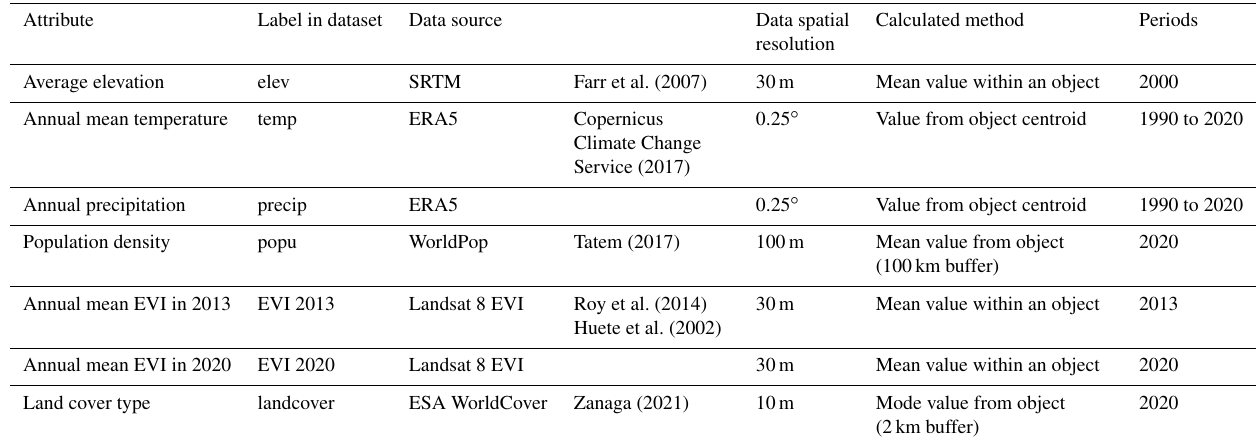
Table 2. The attributes of the PV power plants in our dataset. Attribute